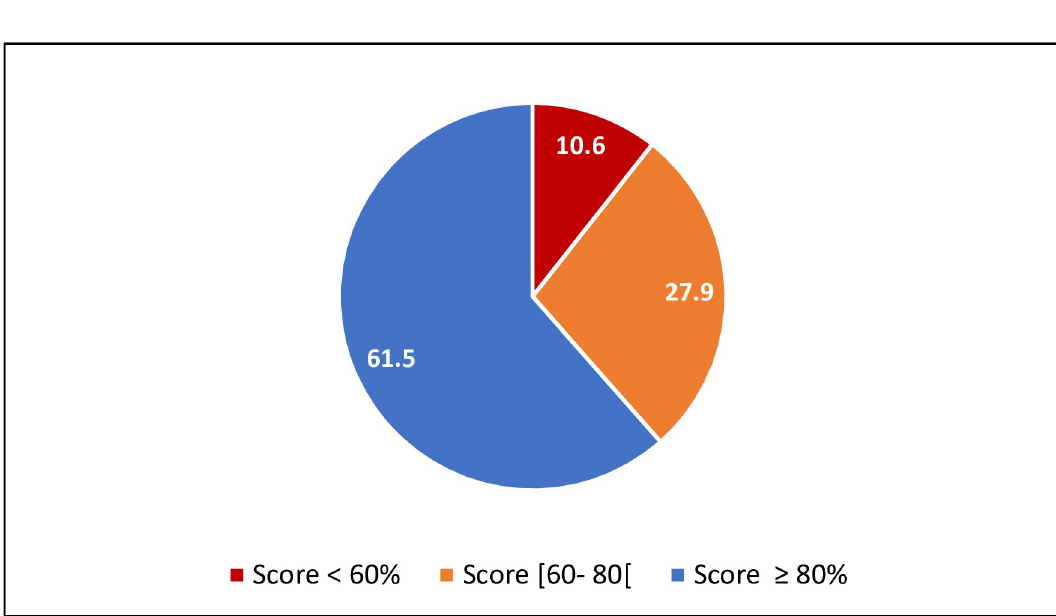
Fig 2. Profile of medical students’ practices